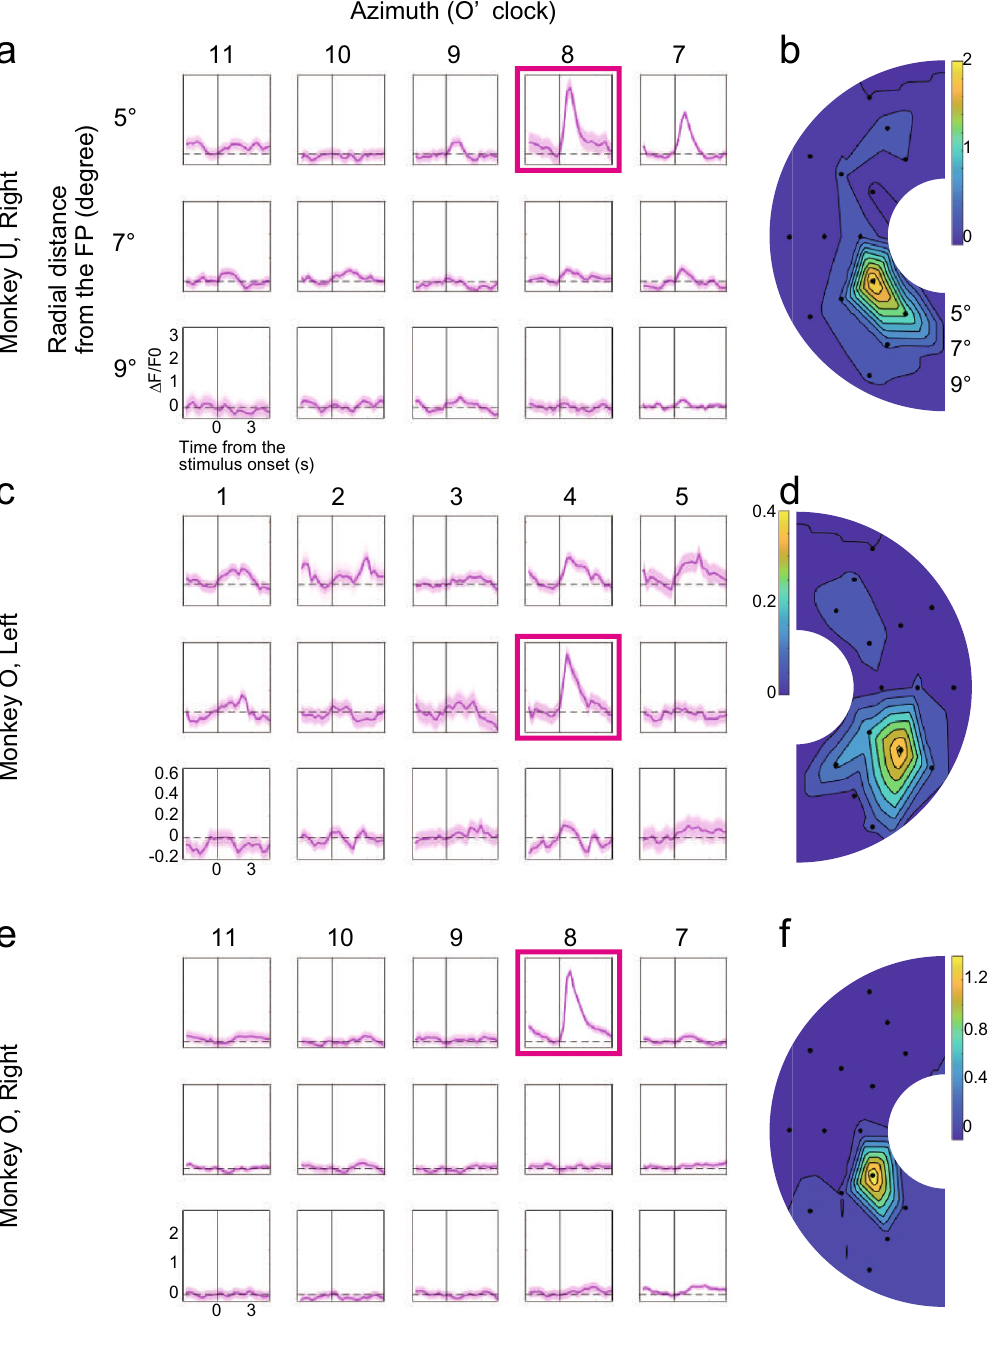
Figure 4. Receptive fields of recorded V1 cells. ( a ) Averaged stimulus responses of a representative ROI at different stimulus positions for the right hemisphere of Monkey U. These panels are arranged according to the azimuth (columns) and eccentricity (rows) of the stimuli. Error areas: standard error of the mean. ( b ) Position of a receptive field depicted by a linear model curve fitting. Color indicates normalized signal strength (ΔF/F0). ( c – f ) The corresponding figures to ( a ) & ( b ) for the imaging data recorded from the left and right hemispheres of Monkey